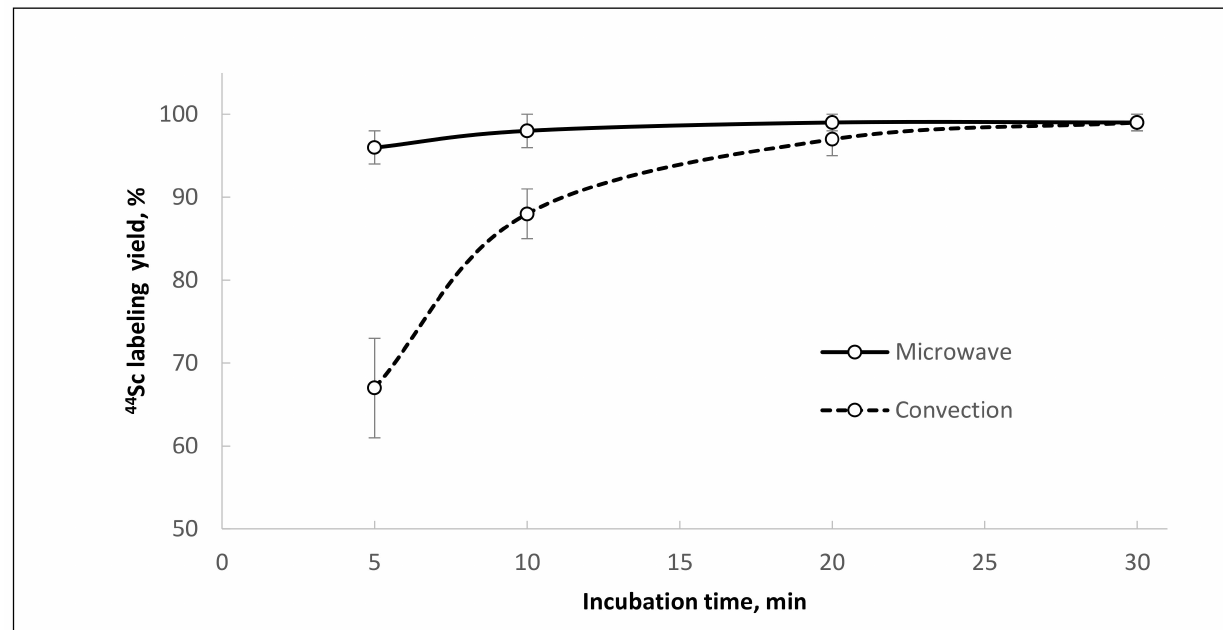
Figure 11. Kinetics of [ 44 Sc]Sc-PSMA-I&T formation using 44 Sc after reformulation with Presep ® PolyChelate into 0.1 M HCl under different heating modes (95 ◦ C, V = 1.0 mL, pH = 4.5, 5 nmol